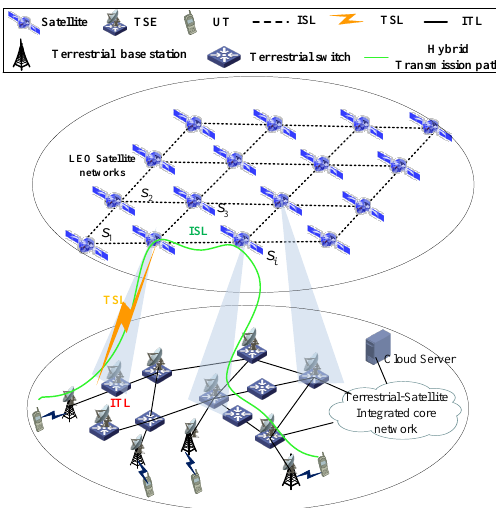
Figure 1. The transmission architecture of